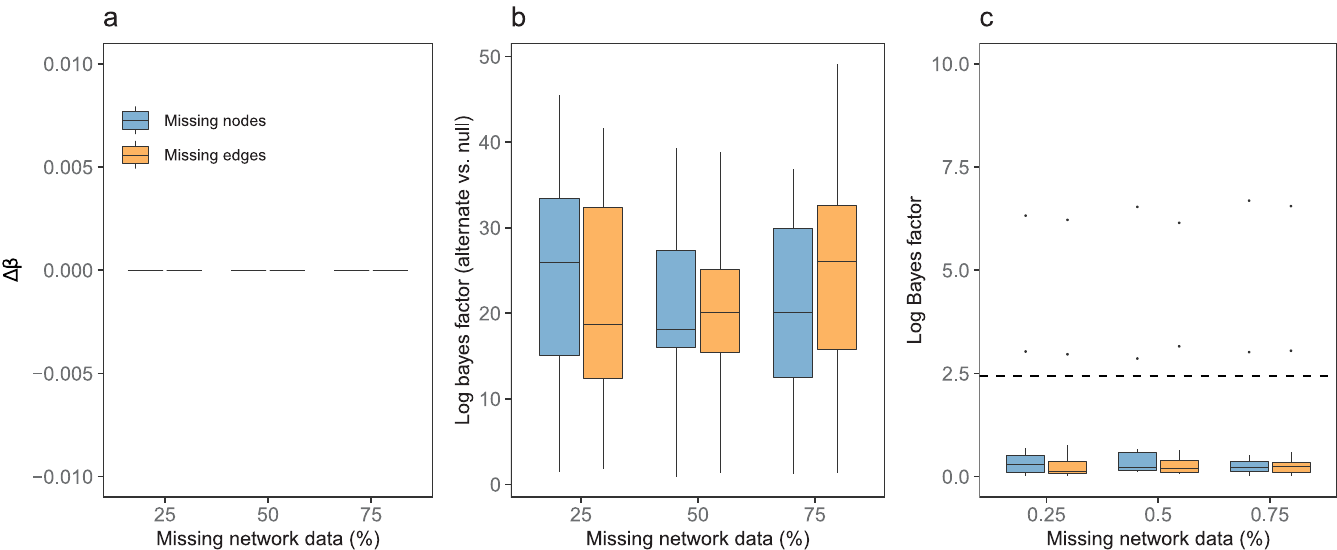
Fig 3. Robustness of INoDS to missing network data. Robustness of INoDS to missing nodes and missing edges in network hypothesis. Networks with missing nodes/ edges were created by randomly removing 25–75% of nodes/edges not involved in infection spread path at each time-step from the dynamic synthetic network. (a) Step 1: Δ β is the relative deviation of estimated transmission parameter β from the true transmission rate β � . (b) Step 2: Epidemiological relevance of observed network with missing data. Each box summarizes log Bayes factor of observed network with missing data compared to null hypothesis (viz a prior of networks with 10% to 100% permuted edges). (c) Evidence for the true synthetic network over datasets with missing data. Log Bayes factor of more than 2.44 (dashed line) is considered to be a strong support in favor of the observed contact network. The middle black line in each box plot is the median, the boxed area extends from the 25th to 75th quartile, and whiskers extended from the hinge to the largest/smallest value no further than 1.5 times the inter-quartile range.